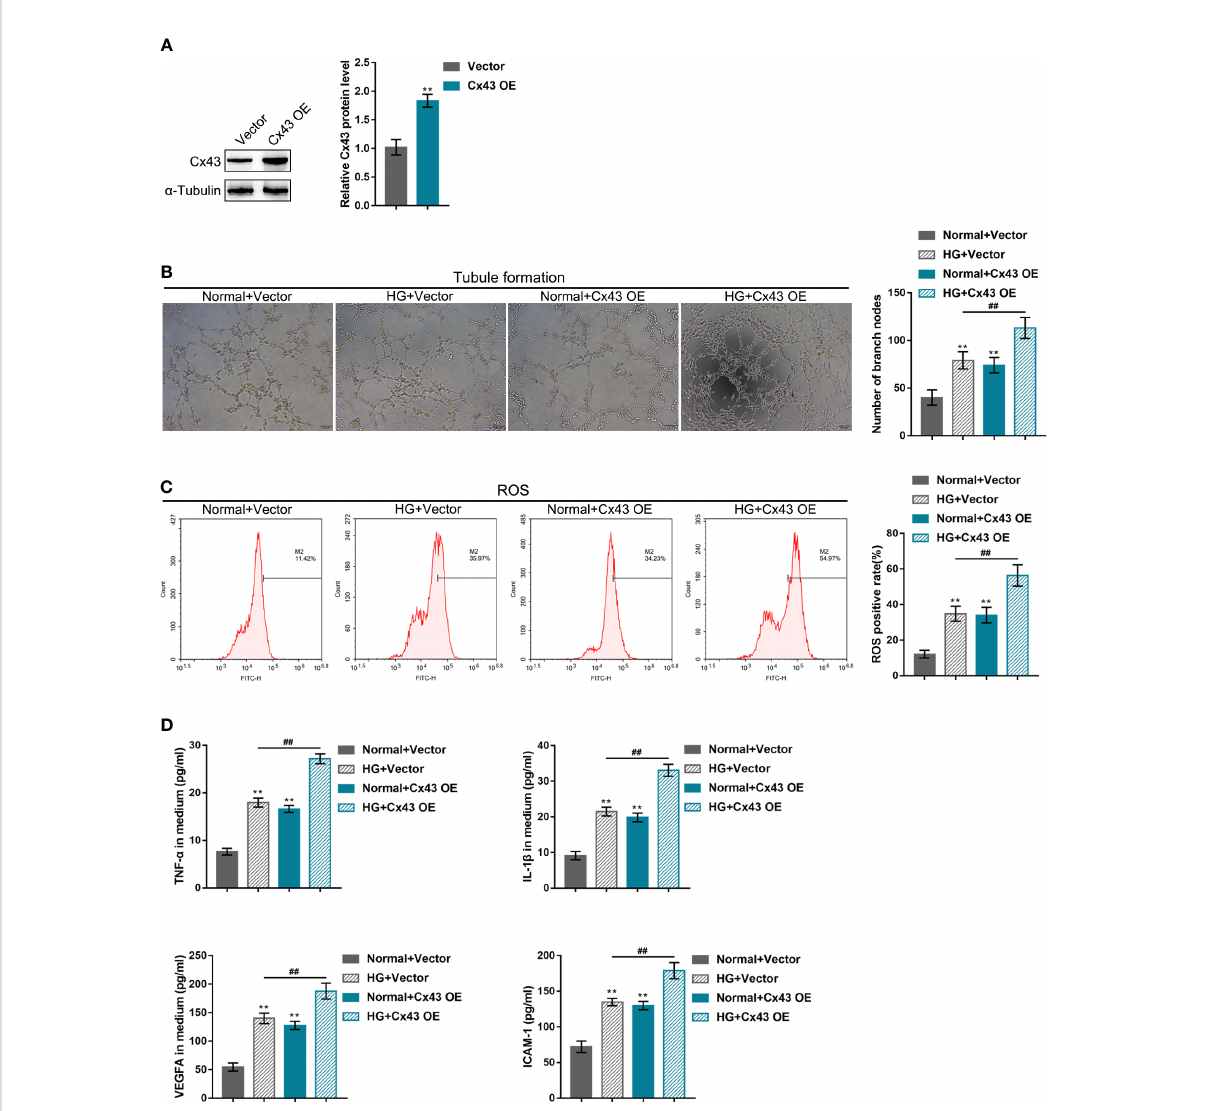
FIGURE 3 Effects of Cx43 overexpression on HG-induced angiogenesis (A) Cx43 overexpression in hRECs was achieved through transfection of the vector containing Cx43 gene coding sequence (Cx43 OE); Cx43 overexpression was con fi rmed using Immunoblotting. hRECs were subsequently transfected with Cx43 OE, cultured in normal or 60 mmol/L HG medium, and examined for tubule formation on Matrigel (B) ; ROS release using fl ow cytometry (C) ; the content of TNF- a , IL-1 b , VEGFA, and ICAM-1 in culture medium using ELISA kits (D) . n = 3, **p < 0.01 compared with normal+vector group; ## p < 0.01 compared with HG+vector